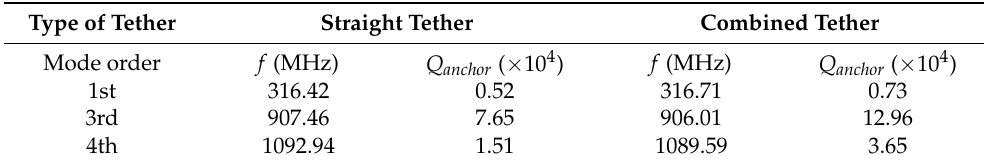
Table 2. Comparison between the simulated frequency and Q anchor of the resonators with the straight tethers and with the combined tethers.